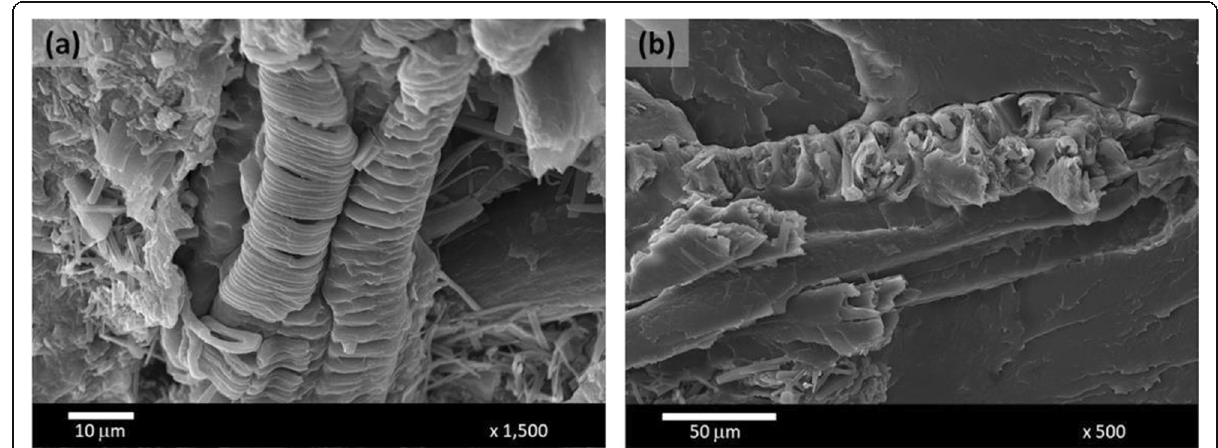
Fig. 5 Coffee husk spiral-like structure formed by exfoliation during melt mixing process of PE-I-40 partially filled with polyethylene (a) and fully filled with polyethylene (b)